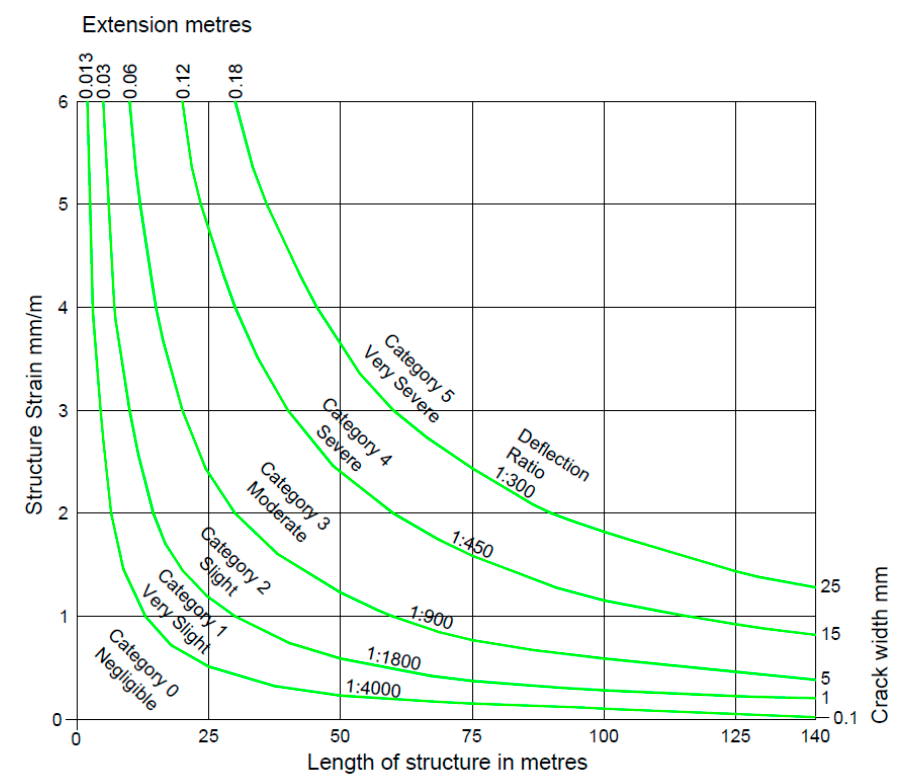
Figure 5. Impact classification with deflection ratios for two-storey brick structures [46].